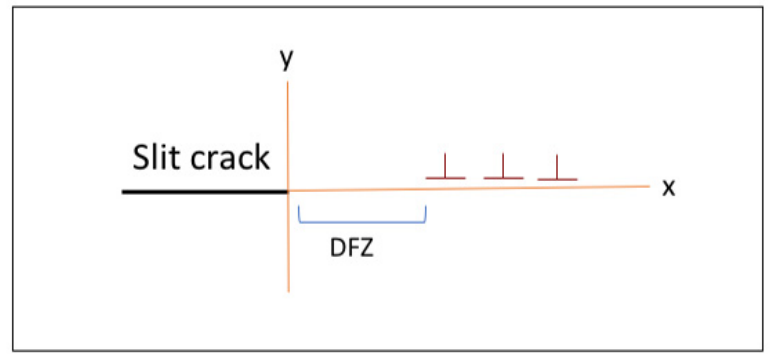
Figure 4. A schematic diagram showing the slit crack and the dislocation